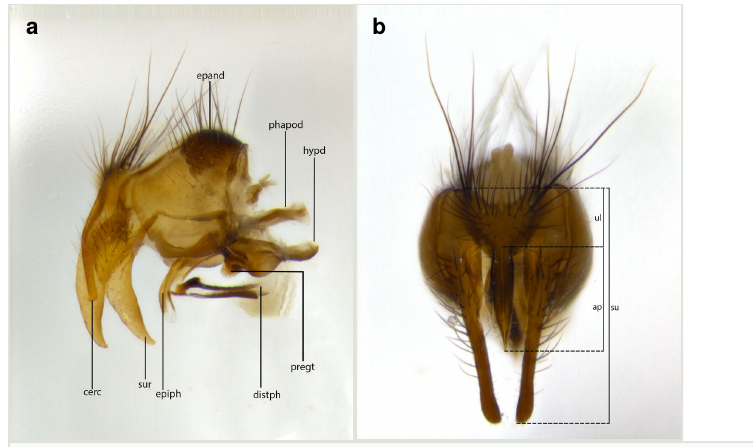
Figure 1. Male terminalia of Uramya spp.; a : lateral view of terminalia of U. nitida sp. nov. ; b : dorsal view of terminalia of U. sibinivora